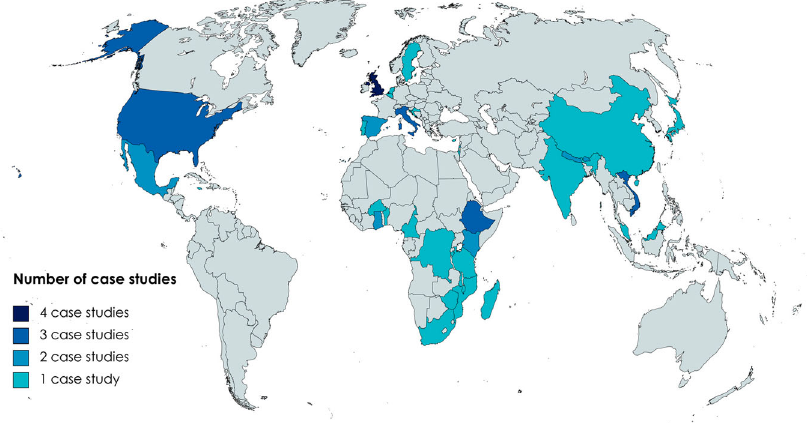
Fig. 3 World map illustrating the origin of case studies. Geographical distribution of case studies using focus groups in CES ( n = 2) or district/region ( n = 2). The number of focus group discussions per study greatly varied with the minimum being one focus group ( n = 5) and a maximum of 42 focus groups ( n = 1), with a median of 5 (Fig. 4c). Usually there was more than one focus group per study, most often three. Two studies did not report the number of focus groups.